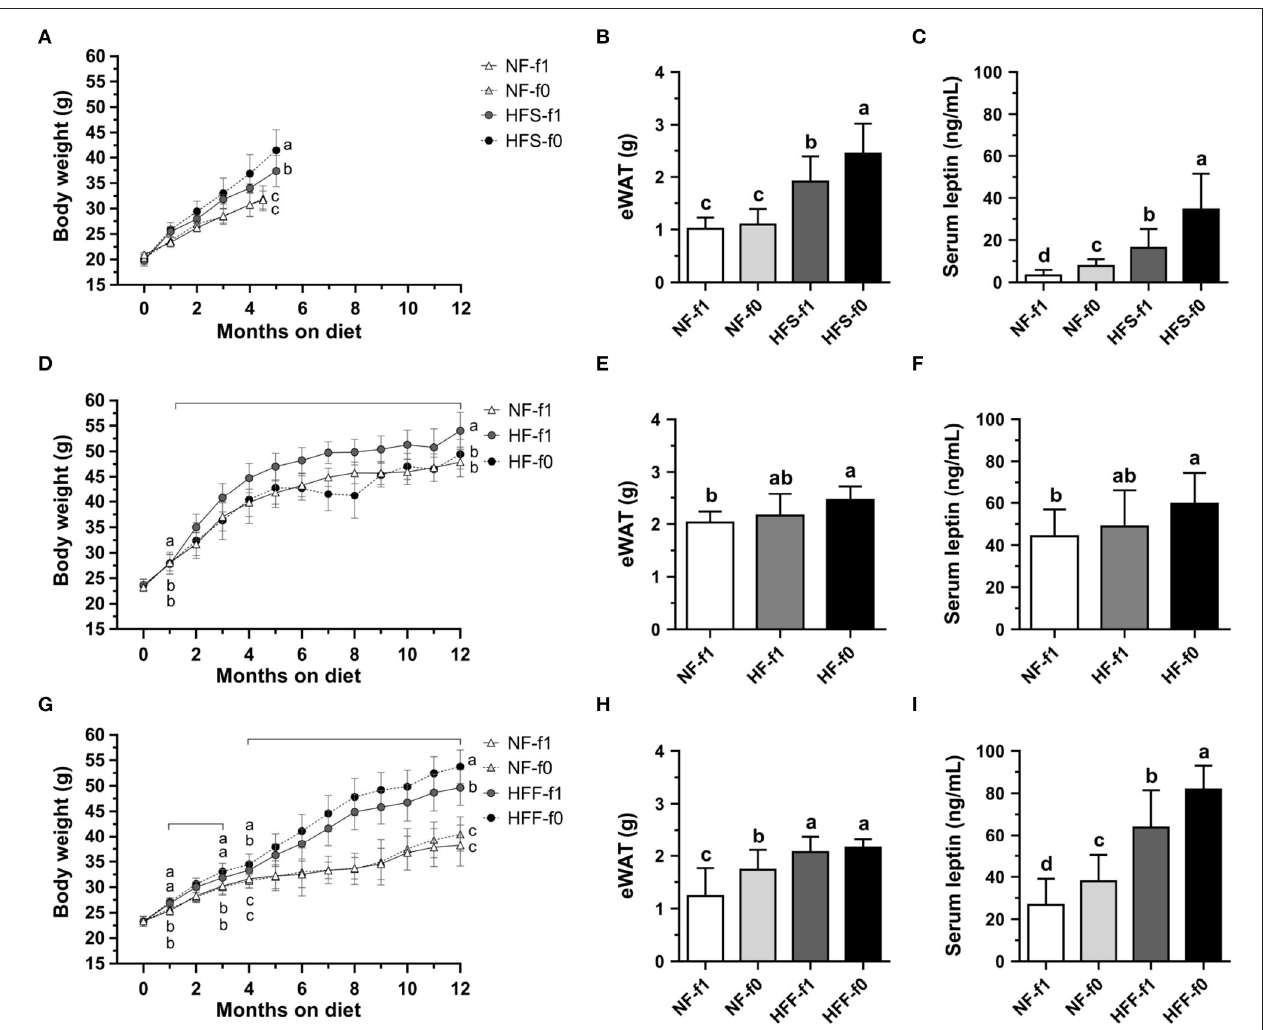
FIGURE 3 | Folate deficiency increased adipose tissue mass and sera leptin levels of mice fed either NF, high-fat high-sucrose (HFS), high-fat (HF), or high-fat high-fructose (HFF) diet for 4.5–5 or 12 months. (A) Body weight, (B) epididymal white adipose tissue (eWAT) mass, and (C) serum leptin from NF or HFS diet-fed mice. (D–F) from NF or HF diet-fed mice. (G–I) from NF or HFF diet-fed mice. Data are mean ± SD ( n = 8–16 per group). The different letters indicate significant differences ( p < 0.05) analyzed using one-way ANOVA and Duncan’s post-hoc